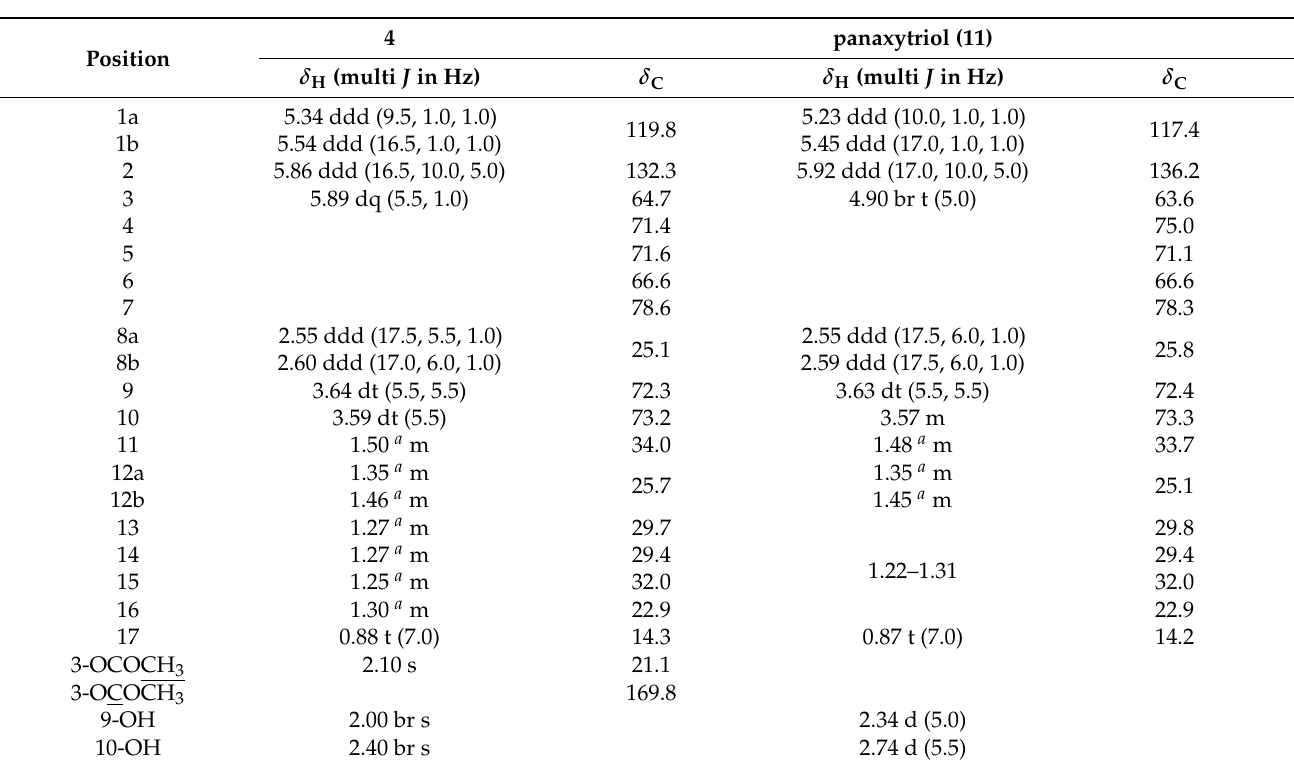
Table 2. 1 H and 13 C NMR spectroscopic data of compound 4 and panaxytriol ( 11 ) ( δ in ppm, chloroform- d , 500 and 125